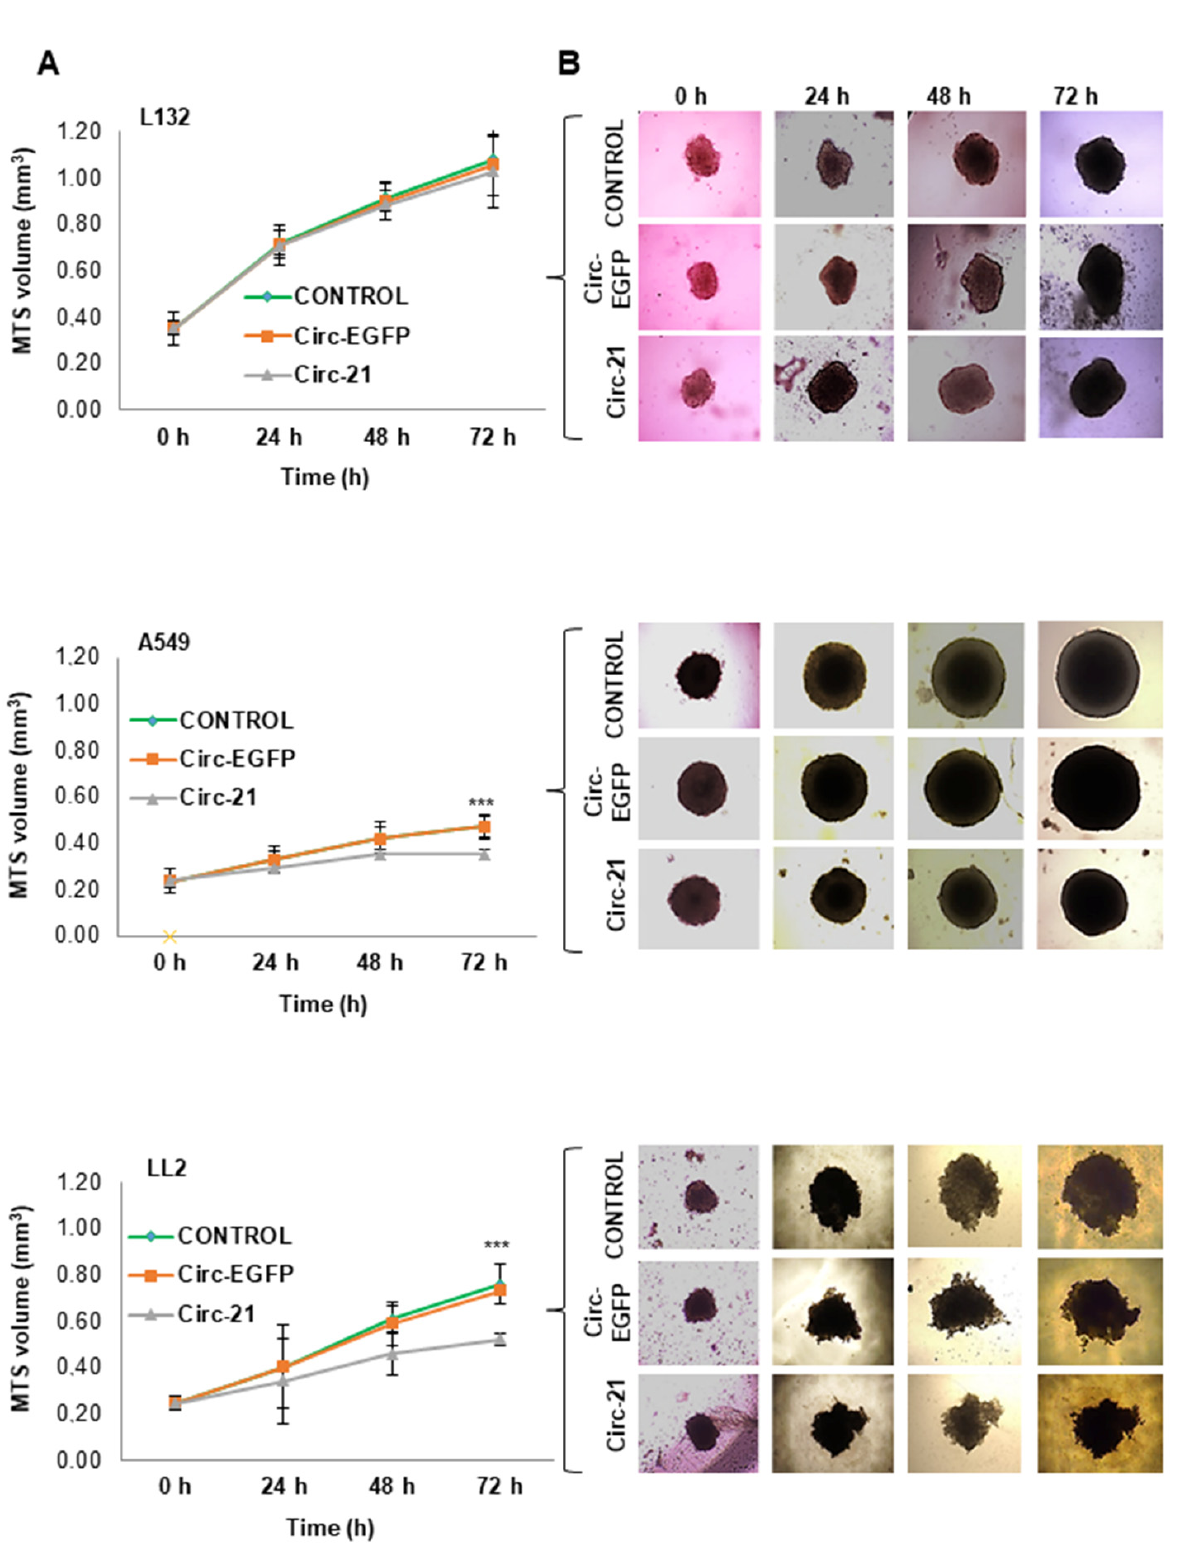
Figure 7. The miR-21 sponge in multicellular spheroids (MTS). ( A ) Volume growth. Values at 24, 48 and 72 h means ± SD of quintupled cultures. Statistical analysis was performed using a two-tailed t -test comparing the different samples against the control. *** p < 0.001. Only statistically significant differences are shown and indicated with asterisks. ( B ) Representative microscopy images of MTS.